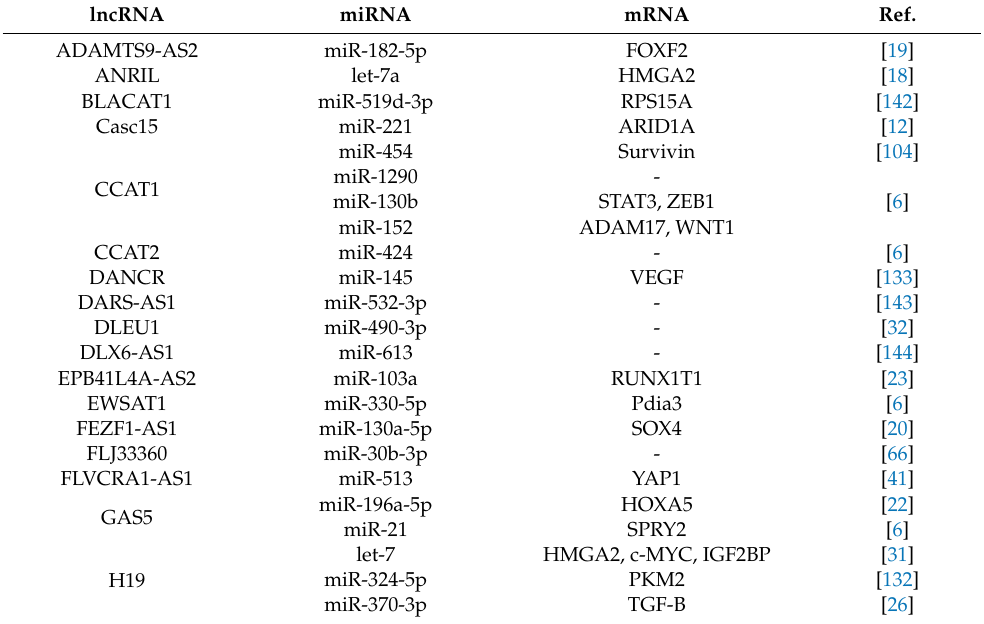
Table 5. LncRNA–miRNA–mRNA regulatory